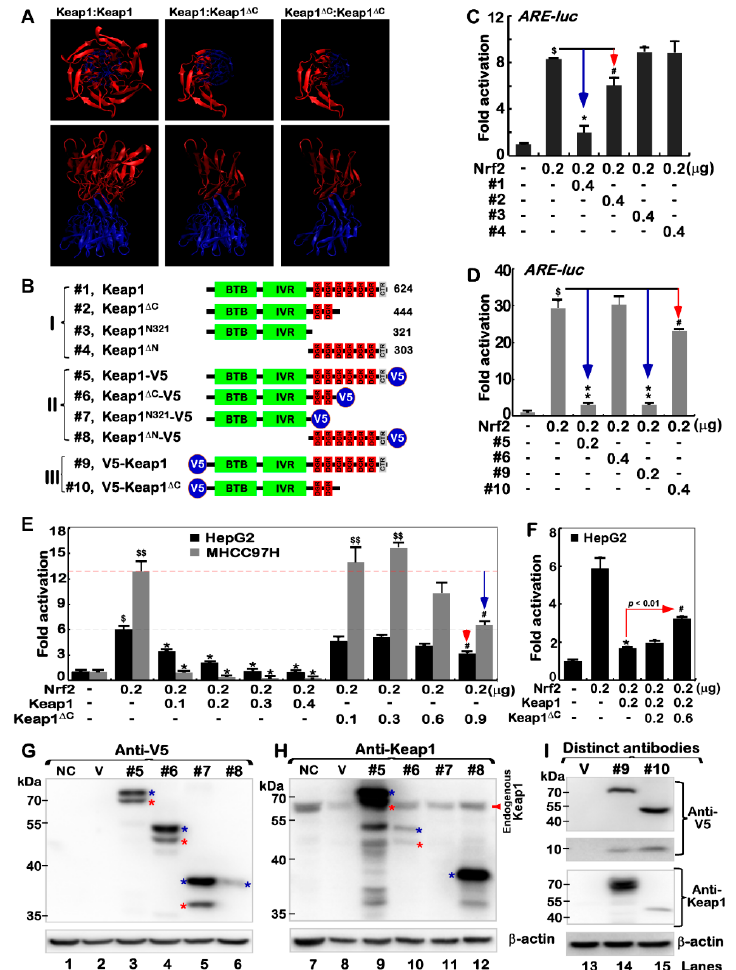
Figure 4. Keap1 ∆ C competes against effects of Keap1 on the Nrf2-mediated reporter gene. ( A ) Three distinct dimers of Keap1 and Keap1 ∆ C with different views were simulated by the VMD1.9.3 software, based on a template of the crystal structure of Keap1 (3WN7 deposited in PDB). ( B ) Shows schematic of the structural domains of Keap1, Keap1 ∆ C , as well as other mutants Keap1 N321 and Keap1 ∆ N , some of which were tagged by the V5 ectope at the N-terminal or C-terminal ends. ( C , D ) HepG2 cells were co-transfected with an Nrf2 expression construct, and both reporters of pARE-Luc and pRL-TK (as an internal control), together with Keap1, Keap1 ∆ C and other mutants as indicated. After 24 h, luciferase activity was measured with significant changes ($ p < 0.001 compared to the normal control group; # p < 0.01, * p and ** p < 0.001 compared to the Nrf2-positive group; n = 3 × 3; the color arrows indicate comparison with the control group). ( E ) HepG2 and MHCC97H cell lines that had been co-transfected with a Nrf2 expression construct and two reporters pARE-Luc and pRL-TK , in combination of distinct cDNA concentrations of Keap1 or Keap1 ∆ C , were subject to luciferase assays to determine ARE-driven reporter activity with significant increases ($ p < 0.01; $$ p < 0.001 compared to the normal control, n = 3 × 3) or significant decreases ( * , # p < 0.01, compared to the positive Nrf2; n = 3 × 3). ( F ) Besides an Nrf2 plasmid and two reporters, pARE-Luc and pRL-TK , different concentrations of Keap1 and/or Keap1 ∆ C alone or in combination were co-transfected into HepG2 cells. Then reporter gene activity was measured with significant changes ( n = 3 × 3; * p < 0.001; # p < 0.01 compared to the Nrf2 positive group; the color arrows indicate comparison with the control group). ( G – I ) Expression constructs for Keap1-V5 (#5), Keap1 ∆ C -V5 (#6), Keap1 N321 -V5 (#7), Keap1 ∆ N -V5 (#8), V5-Keap1 (#9) or V5-Keap1 ∆ C (#10), along with an empty pcDNA3 vector as the negative control (i.e., V), were transfected into HepG2 cells, respectively. The total lysates of either transfected or untransfected as a normal control (i.e., NC) cells were then analyzed by Western blotting with antibodies against Keap1 and its V5 tag. The blue “*” indicates the larger strip, the red “*” indicates the smaller